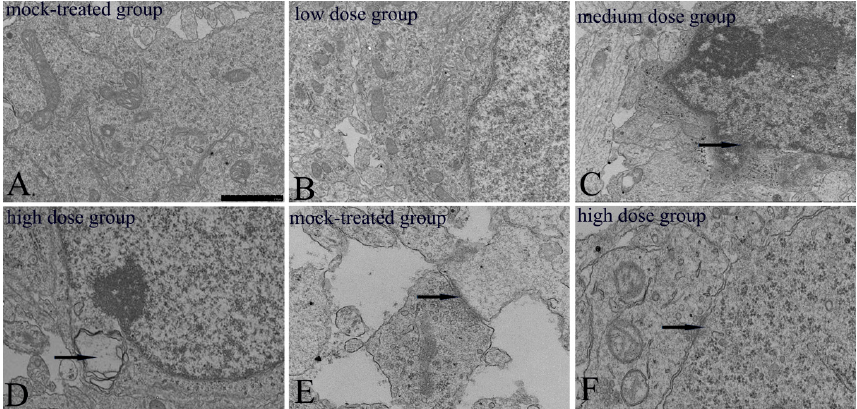
Figure 2. Ultrastructural changes of cerebral cortex neurons and synapses in mice offspring after maternal exposure to PM 2.5 during pregnancy. ( A ) mock-treated group, normal neuron; ( B ) low-dosage group, no significant changes in the neuron; ( C ) The arrow shows the indistinct nuclear membrane; ( D ) the arrow shows the autophagic body; ( E , F ) the arrow shows the synapse. Bar = 1.0 µm.